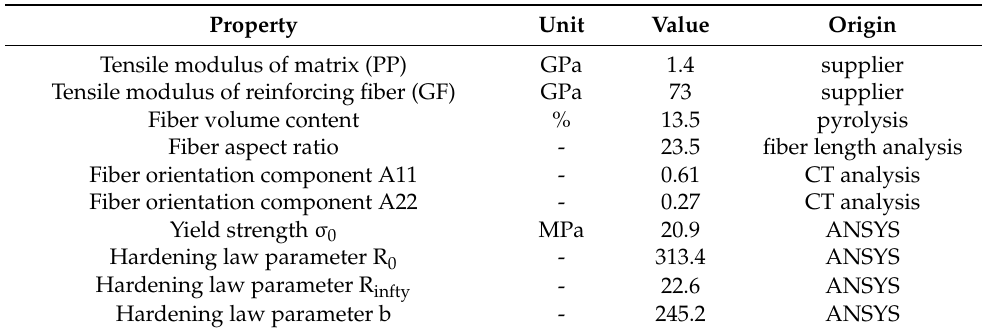
Table 4. Numerical simulation input parameters of the PP/GF30 short fiber-reinforced thermoplas- tic composite.